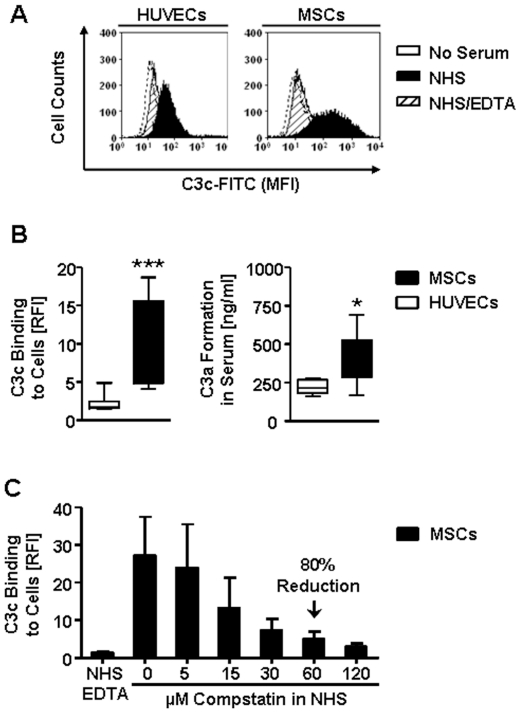
MSCs and ECs activate complement to different degrees.Freshly trypsinized MSCs (black) and HUVECs (white) were exposed to complement active normal human serum (NHS) in order to study the cell surface binding of complement activation products with flow cytometry. (A) Histogram overlays for binding of anti-C3c antibody to non-serum-treated cells (empty, dotted), NHS- (black), or NHS/EDTA-treated cells (shaded) is shown after a 20 min incubation with the respective sera at 37°C. Complement-inactivated NHS (NHS/EDTA) served as negative control. (B) Box plots (whiskers min/max) for anti-C3c binding (RFI, left panel, n = 11) and C3a generation in supernatants (ng/ml, right panel, n = 8) after incubation of cells with NHS, the relative fluorescence intensity (RFI) was calculated compared to non-serum-treated cells. The data are expressed as means±SEM, *P<0.05, and ***P<0.001. (C) Inhibition of C3 fragment binding after pre-treatment of NHS with different doses (5-120 µM) of specific C3-inhibitor Compstatin (n = 5).